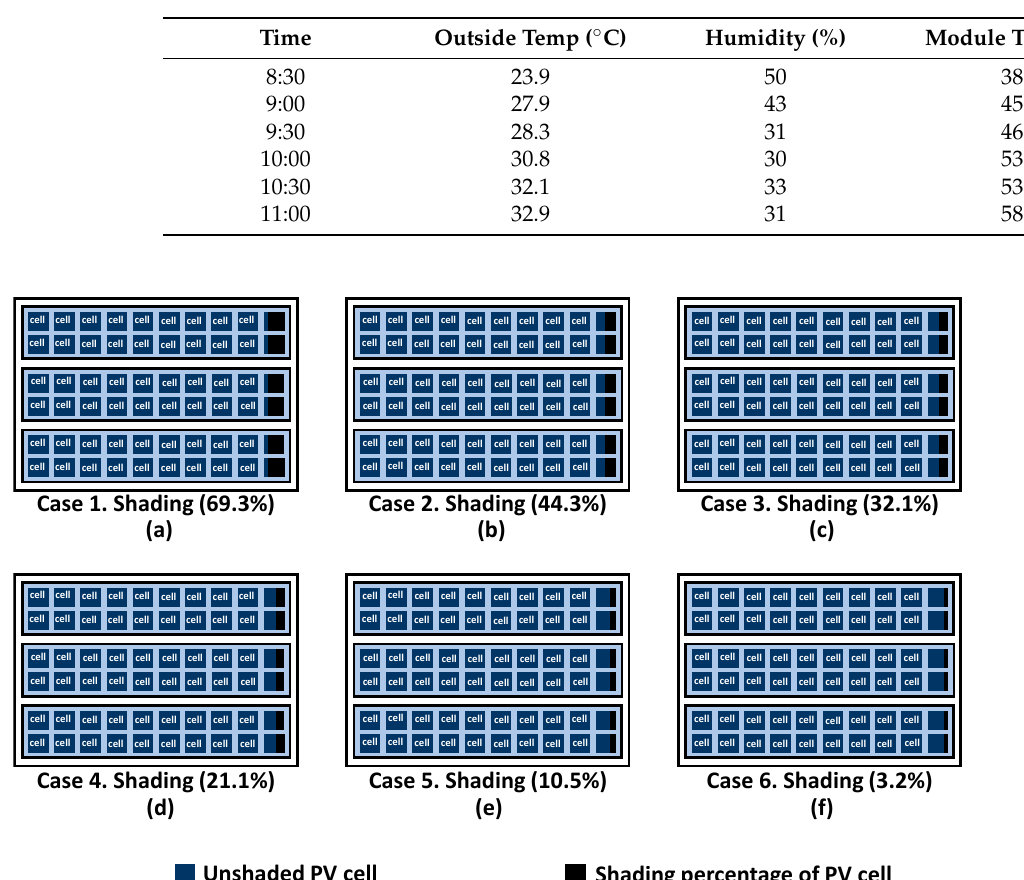
Figure 4. Partial shading conditions of PV modules in the PV array A configuration. ( a ) Case 1, ( b ) case 2, ( c ) case 3, ( d ) case 4, ( e ) case 5, and ( f ) case